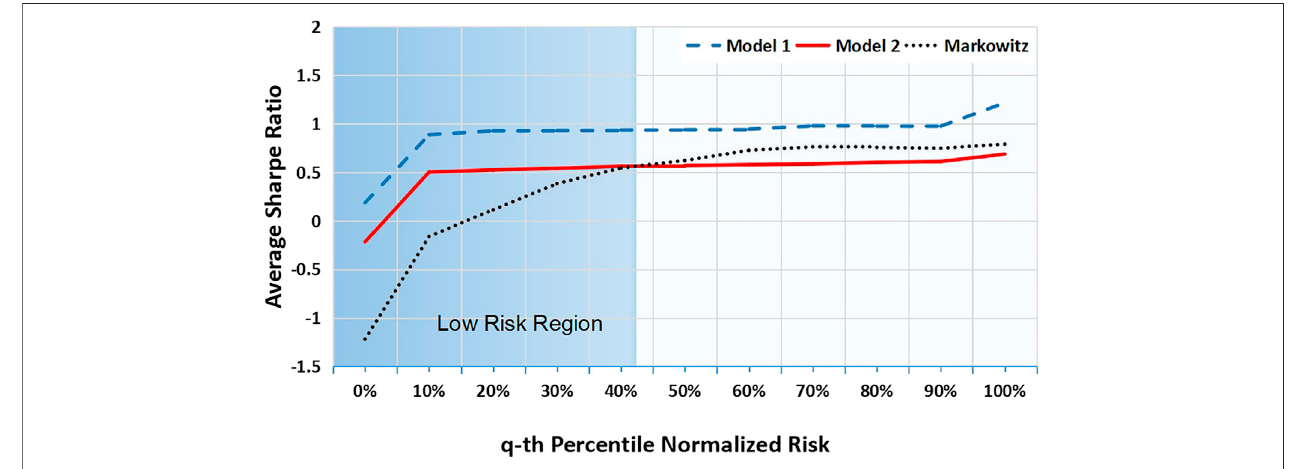
FIGURE 4 | Fundamental Network Ef fi cient Frontiers Model Out-of-Sample Performance. Model 1 (blue) is generally more mean-variance ef fi cient than the benchmark while Model 2 (red) only outperforms in the low risk region ( q ≤ 45 % ). Mean-variance ef fi cient frontier is the benchmark (black).